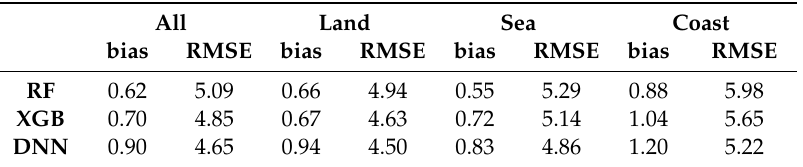
Table 5. Accuracy assessment based on ERA-Interim TPW for the RF, XGB, and DNN in Northeast Asia (1st, 25th per month from September 2016 to August 2018). Validation metrics (i.e., bias and RMSE) are calculated over the ‘all’, ‘land’, ‘sea’, and ‘coast’ regions, respectively. All Land Sea Coast bias RMSE bias RMSE bias RMSE bias RMSE